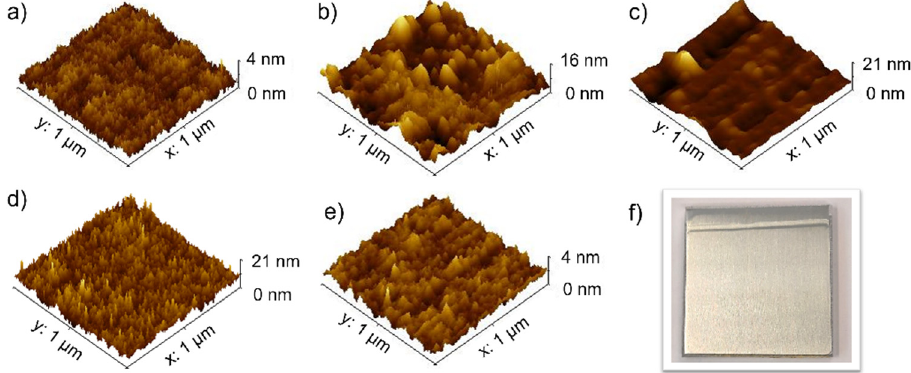
Figure 4. AFM surface maps of the PMMA–silica coatings prepared with increasing concentrations of lithium; ( a ) Li0 (PMMA–silica), ( b ) Li05, ( c ) Li1, ( d ) Li2, ( e ) Li4, and ( f ) image of the Li2 coating on AA7075 alloy.